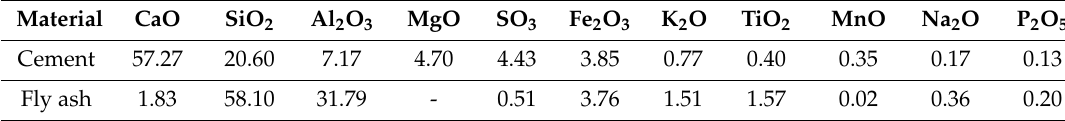
Table 3. Chemical composition of cement and fly ash (%).